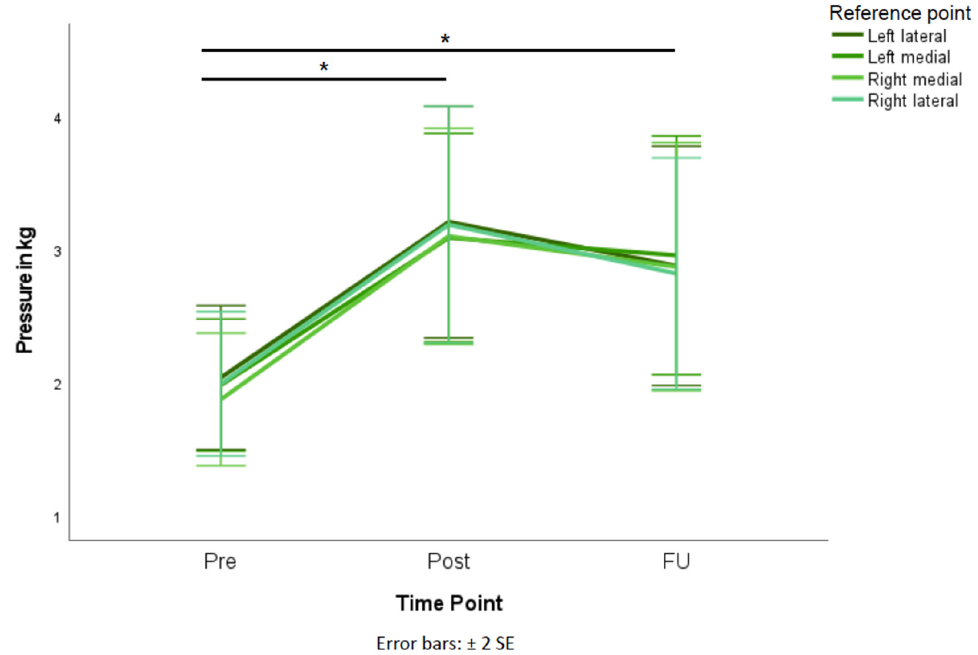
Figure 1. PPT results above each reference point before the first rNMS session (pre), before the last rNMS session (post), and at FU (n = 22 with complete FU). Significant differences are marked with an asterisk (*) and apply to changes at all 4 reference points. Error bars are depicted as ± 2 standard errors (SE). Table 3. Comparison of PPT changes across time between the primary headache group and PTH group.